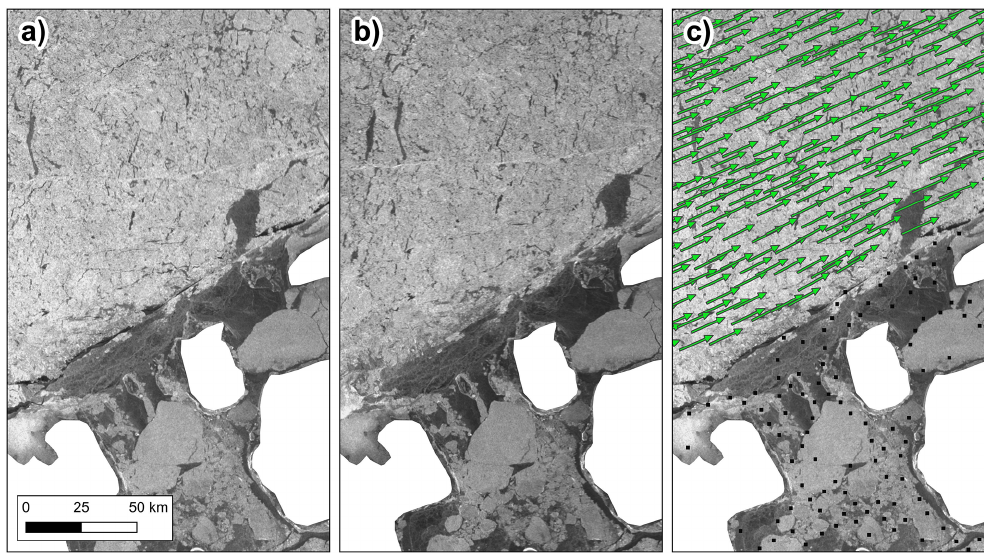
Figure 1. (a) RCM image on 7 April 2020, (b) RCM image on 10 April 2020, and (c) detected sea ice motion vectors (green) over RCM 7 April 2020. The black dots indicate detection vectors with no motion. RADARSAT Constellation Mission imagery © Government of Canada 2020. RADARSAT is an official mark of the Canadian Space Agency.